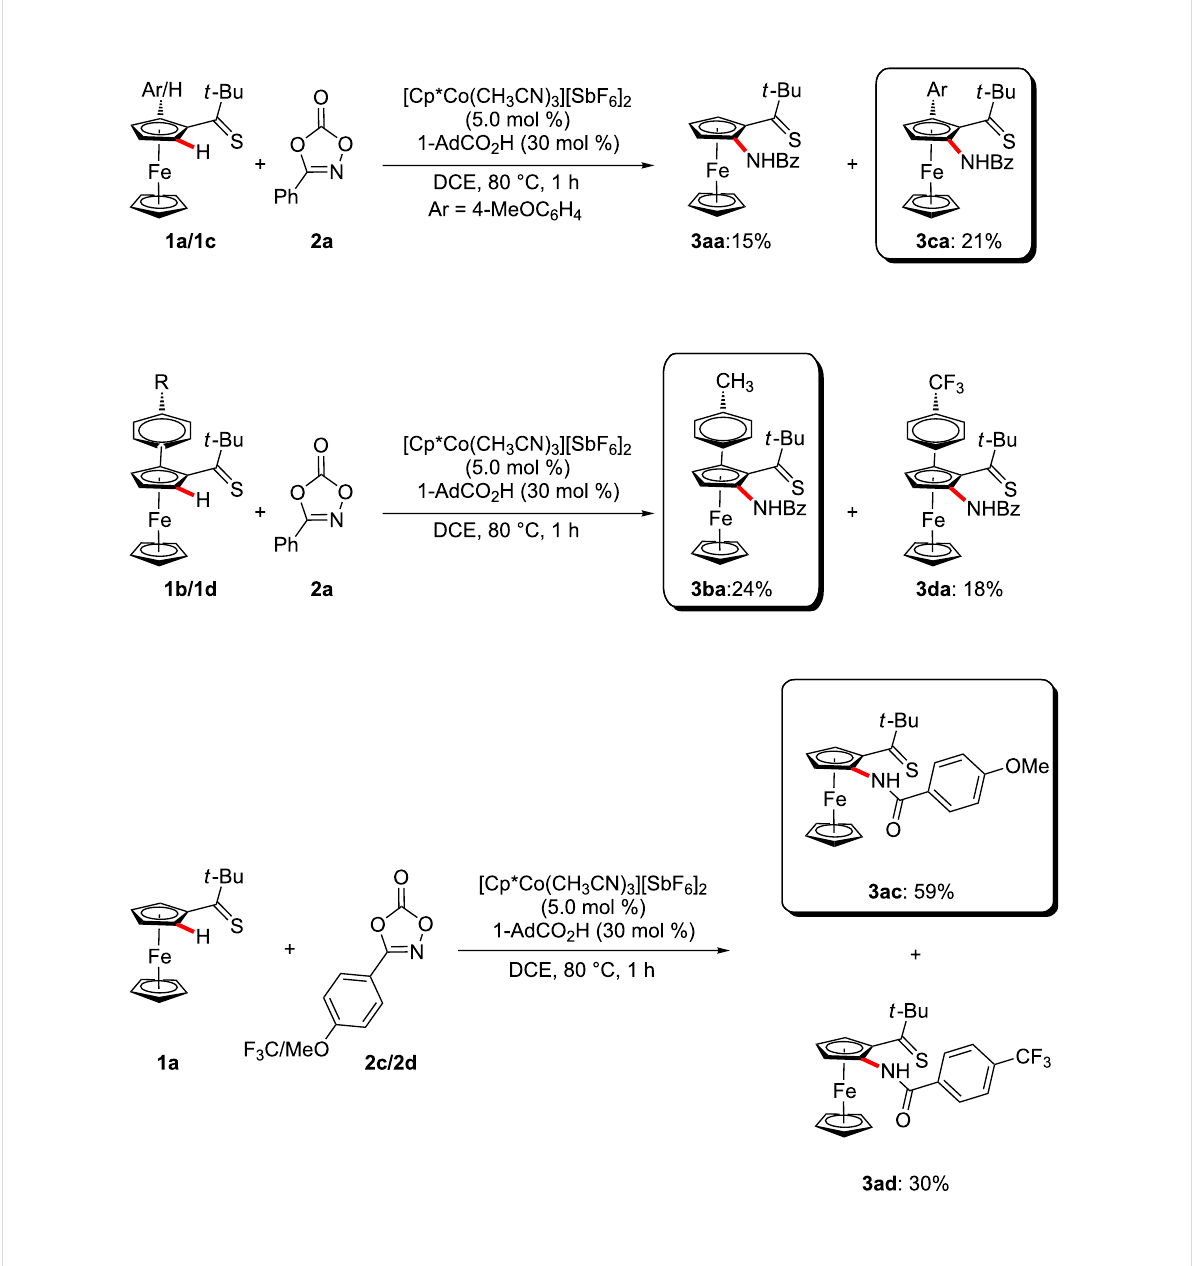
Scheme 5: Intermolecular competition experiments.